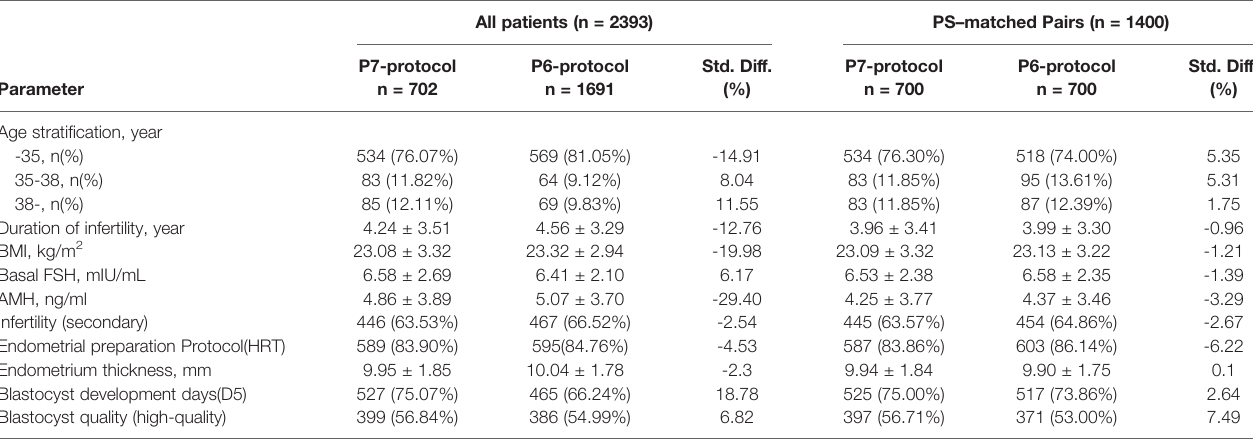
TABLE 1 | Patient characteristics before and after propensity score matching.